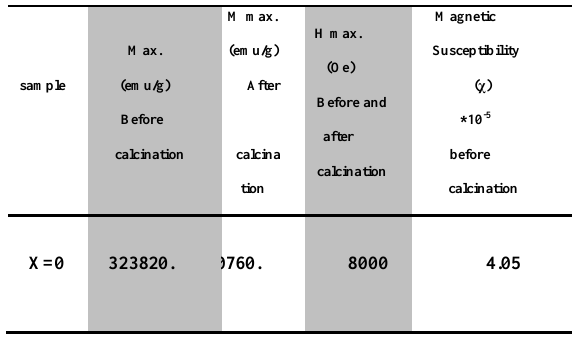
Table 2. Magnetization (M), magnetic field ( samples ( NiO Nanoparticle).